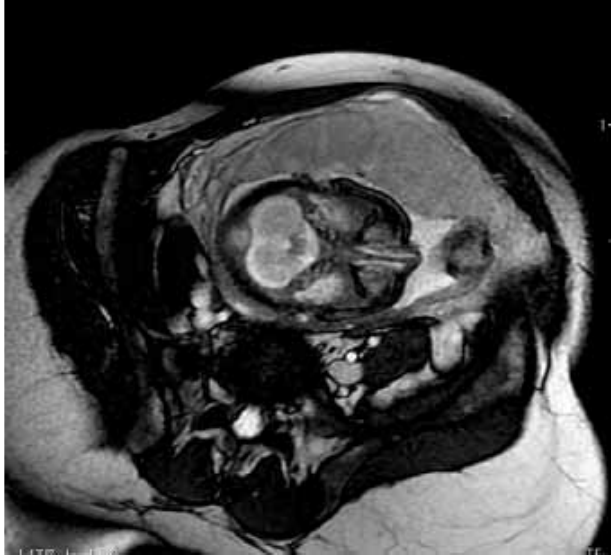
Fig. 4. Case 4: Axial fetal MRI: Well-defined extra-axial lesion situated within the occipital bone. The intracranial posterior fossa structures are